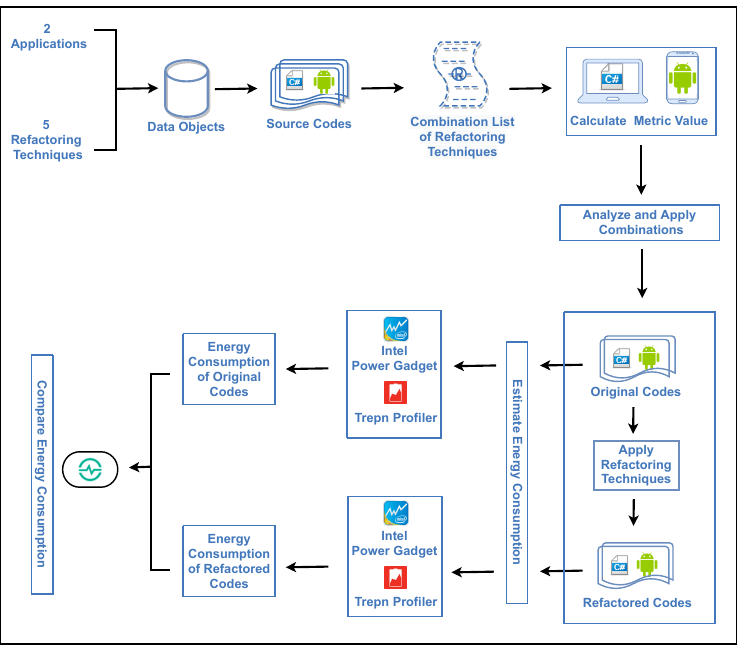
Figure 2. Conceptual